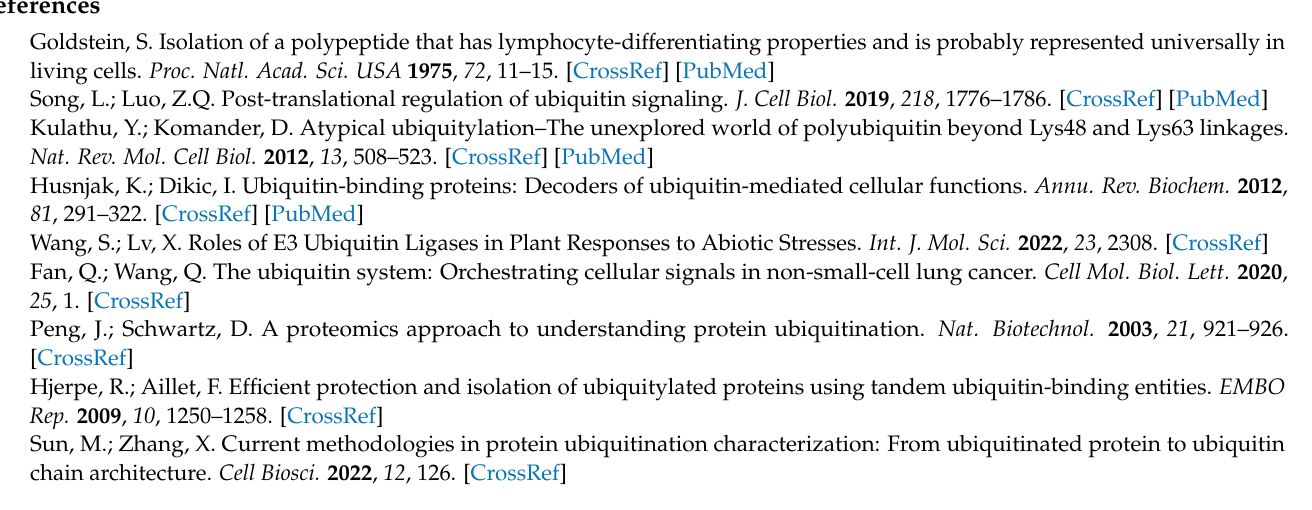
Table S2. DEUPs in the roots of sugar beet M14 plants under 200 mM NaCl stress. Table S3. DEUPs in the roots of sugar beet M14 plants under 400 mM NaCl stress. Table S4. Pro- teins with more than 10 ubiquitination sites in the sugar beet roots after NaCl treatments. Table S5. Proteins modified with both phosphorylation and ubiquitination in the sugar beet roots after NaCl treatments. Table S6 Specific content of GO enrichment. Table S7 Specific content of KEGG enrichment. Table S8 Sugar beet M14 line root proteins with both phosphorylations and ubiquitination. Table S9 Primer sequences required for the